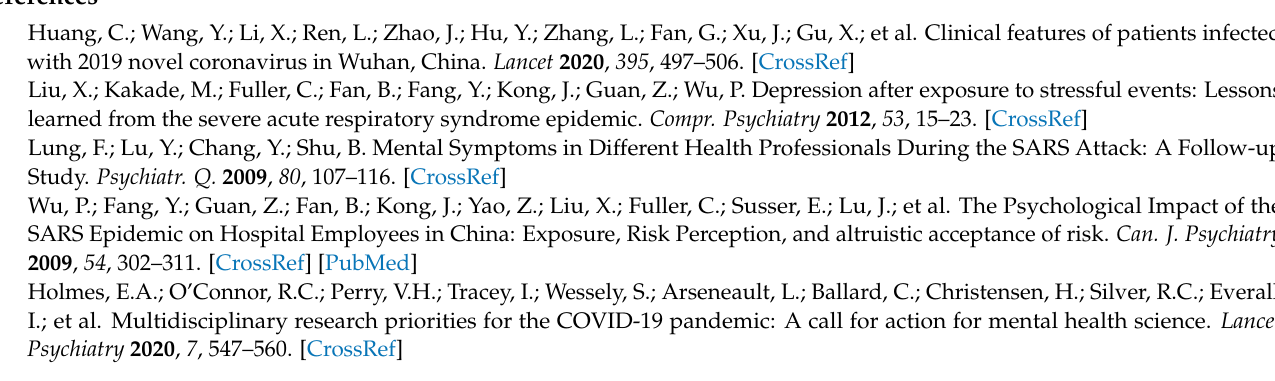
model, Figure S3: MBI_EE linear regression, Figure S4: MBI_PA linear regression, Figure S5: MBI_DE linear regression, Figure S6: IESR logistic regression, Table S1: Skewness/Kurtosis tests for